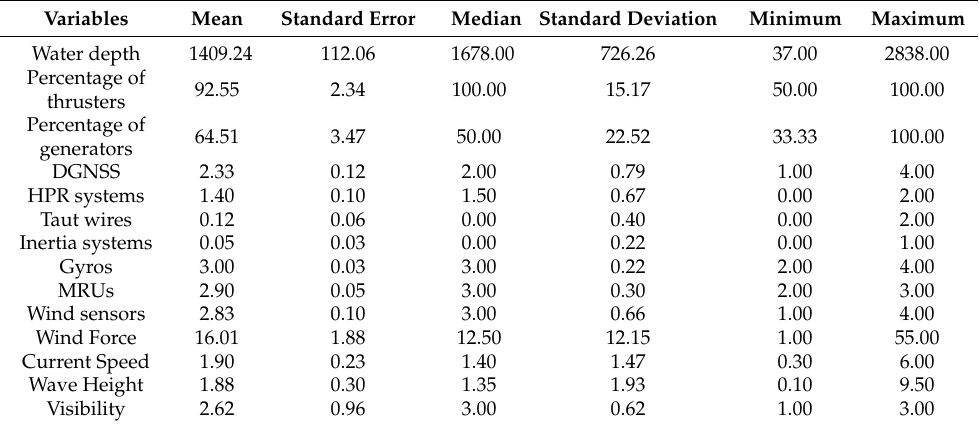
Table 1. Variable descriptions (n =